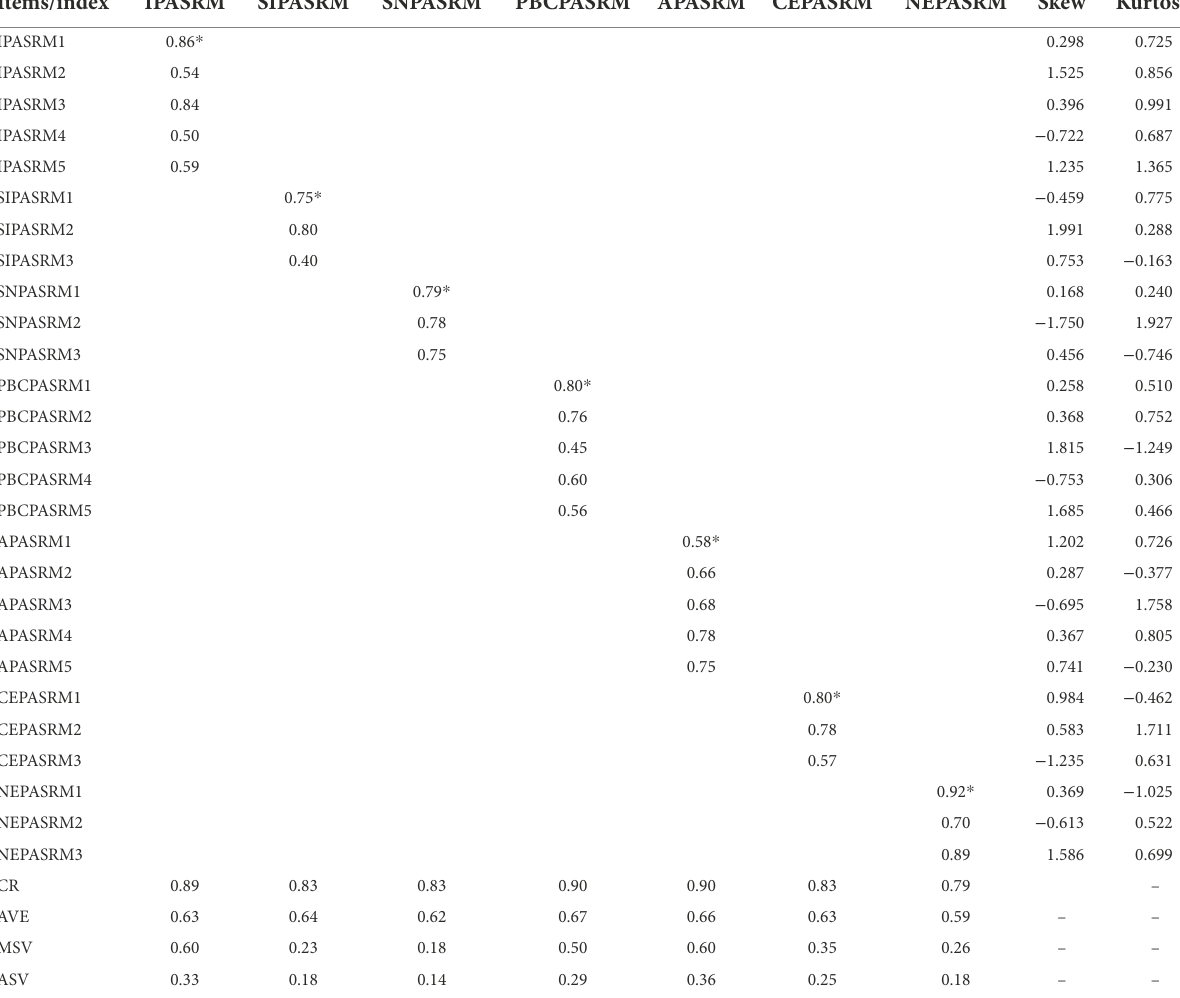
TABLE 3 Th results of estimating measurement model and reliability and validity assessment.